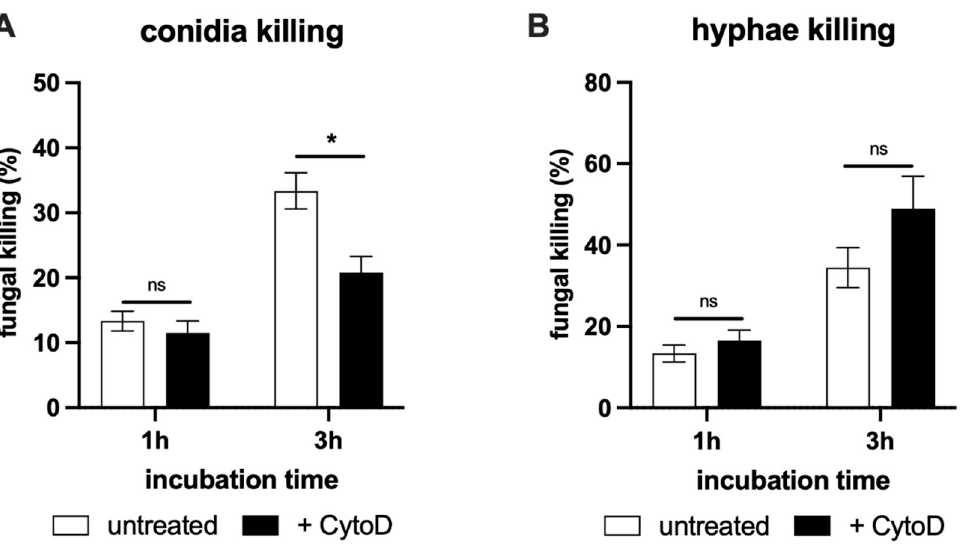
Figure 4. NETs can entrap and kill T. rubrum . ( A ) Conidia or ( B ) hyphae were incubated with neutrophils for the indicated periods with or without cytochalasin D. Fungal viability was tested by the MTT-based colorimetric approach, and the reduction in viable fungi was expressed as the percentage of fungal killing. Data shown as the mean ± SEM. One-way ANOVA and Bonferroni’s post-test: ns, not significant; * p <